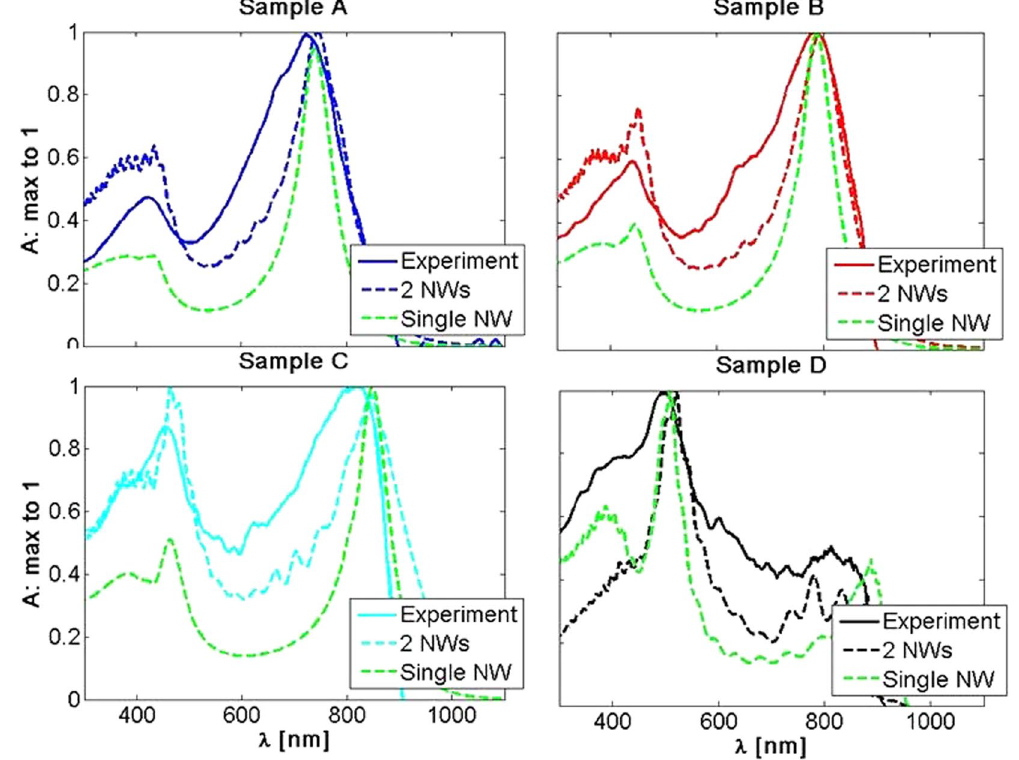
Figure 7. FDTD simulations for two NWs compared with PA technique and single NW spectra, and normalized to